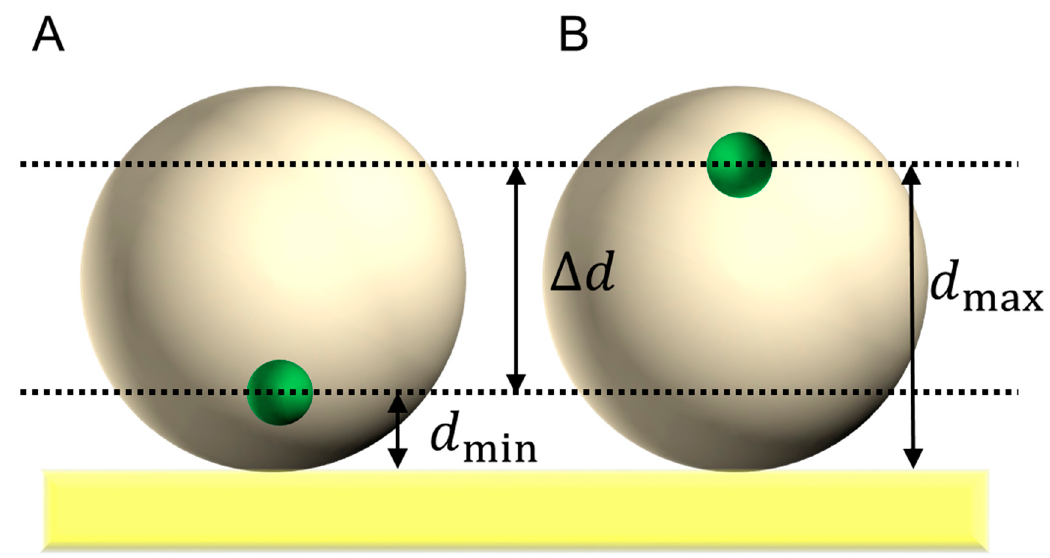
Figure 2. Schematic model of an adsorbed spherical enzyme on a planar electrode in (A) the closest approach of the electrode-active redox center in an enzyme (small spheres) and (B) the farthest approach of the electrode-active redox center.